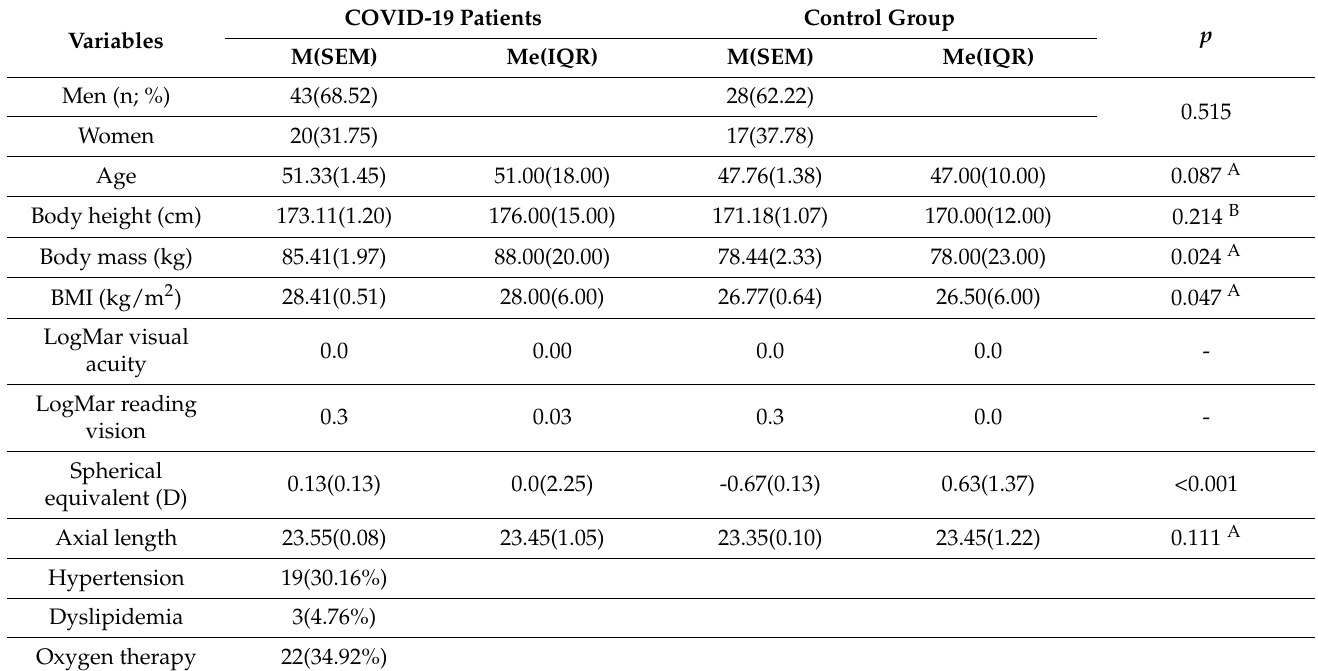
Table 1. Demographic, ocular, and systemic characteristics of the study